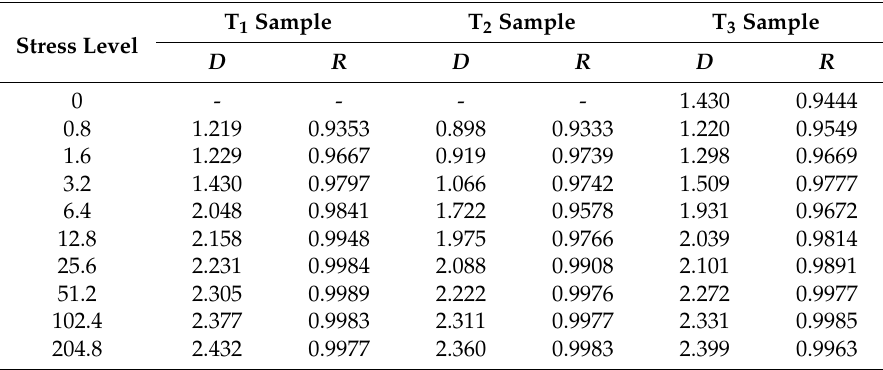
Figure 6. Linear fitting for lg [ M ( δ < d )/ M T ] and lg ( d / d M ): ( a ) T 1 sample, ( b ) T 2 sample and ( c ) T 3 sample. Table 2. Values of fractal dimension and regression coefficient.